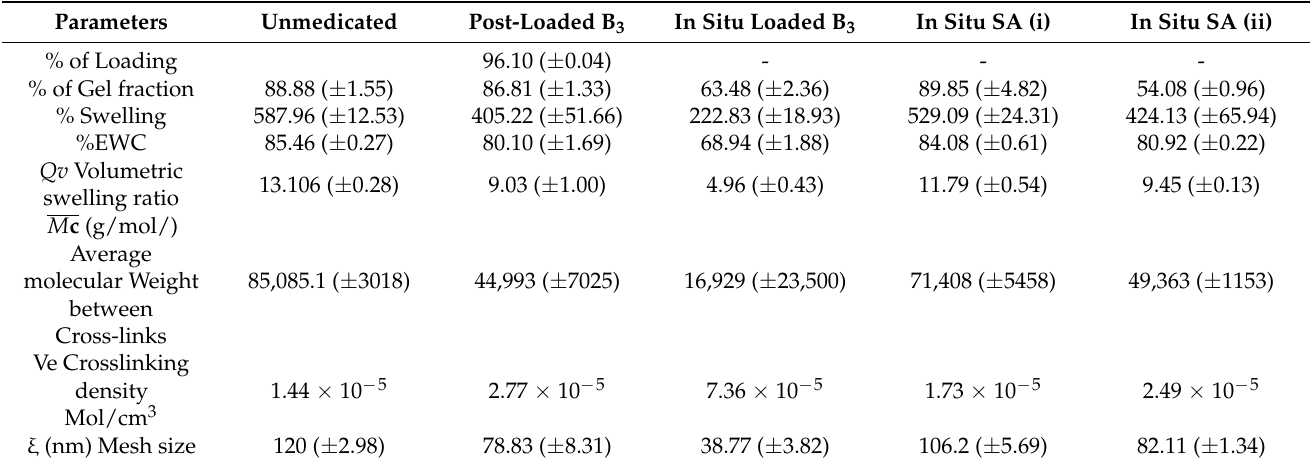
Table 2. Summary of percent of loading, swelling, mesh size and cross-linking behaviour of all loaded hydrogel